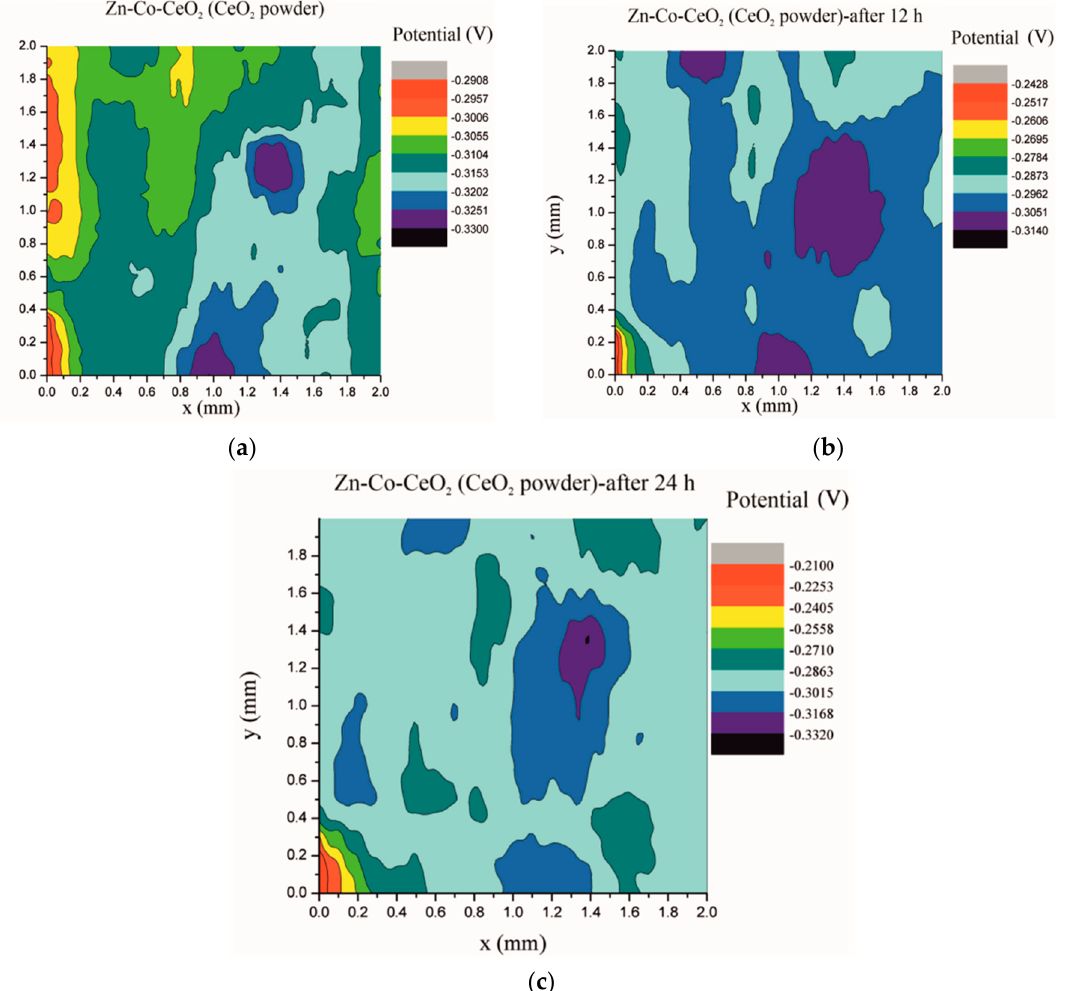
Figure 17. Volta potential surface scan of Zn-Co-CeO 2 (CeO 2 powder) coating: ( a ) initial distribution, ( b ) after 12 h and ( c ) after 24 h in device chamber.